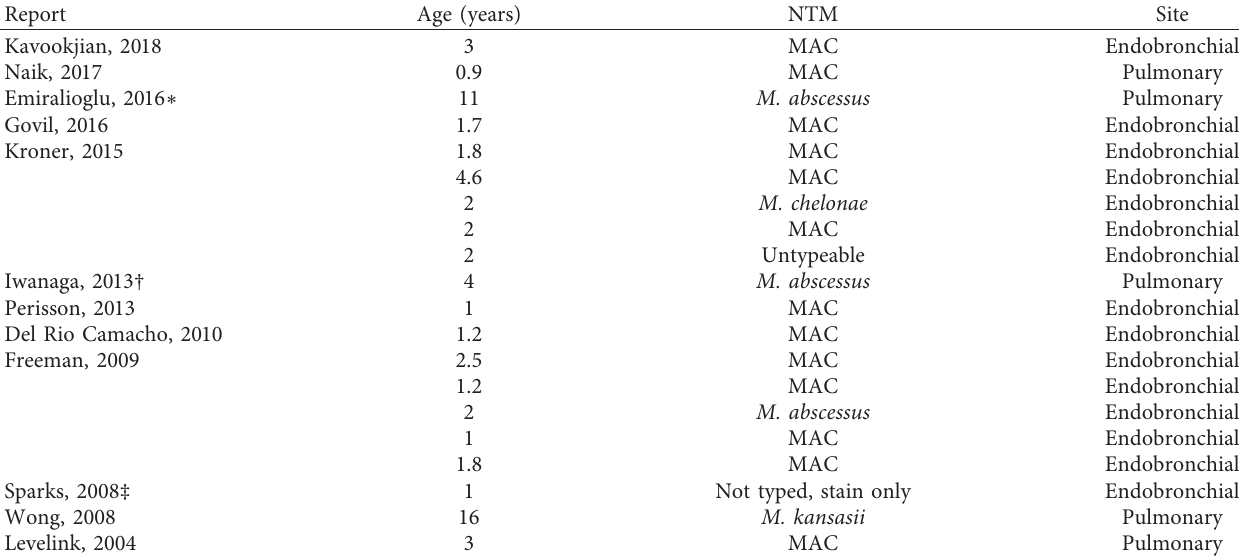
Table 1: Published cases of intrathoracic NTM in patients reported as immunocompetent (from 2004–present, age of patient available).